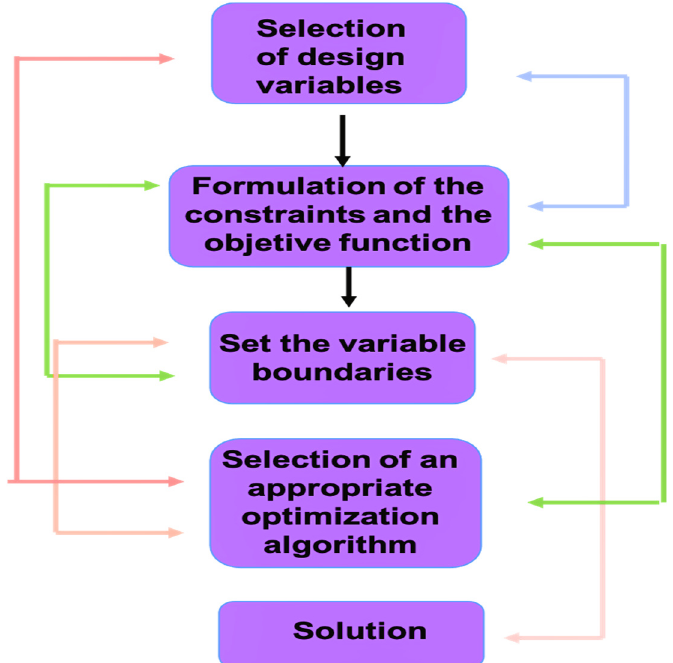
Figure 12. Flowchart for the optimal design. An optimization procedure can be used to obtain optimal solutions concerning various types of engineering problems for choosing the right combination of input parameters.